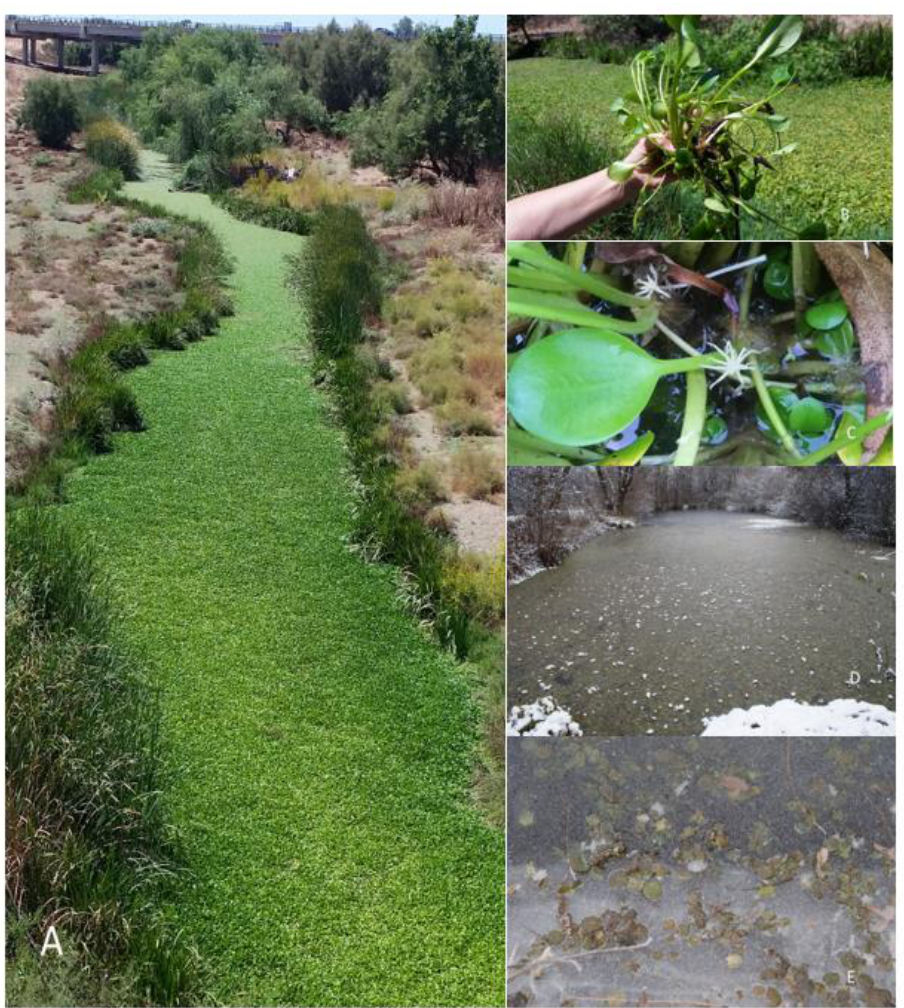
Figure 1. ( A , B ) Hydrocharis laevigata habitat in the outskirts of Seville, Spain. ( C ) Male flowers, photos taken by P. Garcia Murillo in summer 2021; ( D , E ) habitat in the outskirts of Krakow, Poland, photos taken in November and December 2020, courtesy of Dr. Arthur Pliszko.